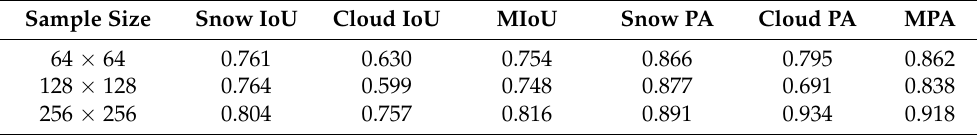
Figure 6. Comparison of cloud and snow identification under different sample sizes. The three columns of subfigures ( a – c ) represent the original image, the label image, and the prediction maps under the sample size of 64 × 64, 128 × 128, and 256 × 256 at three different dates, respectively. Table 4. Comparison of model test accuracy under different sample